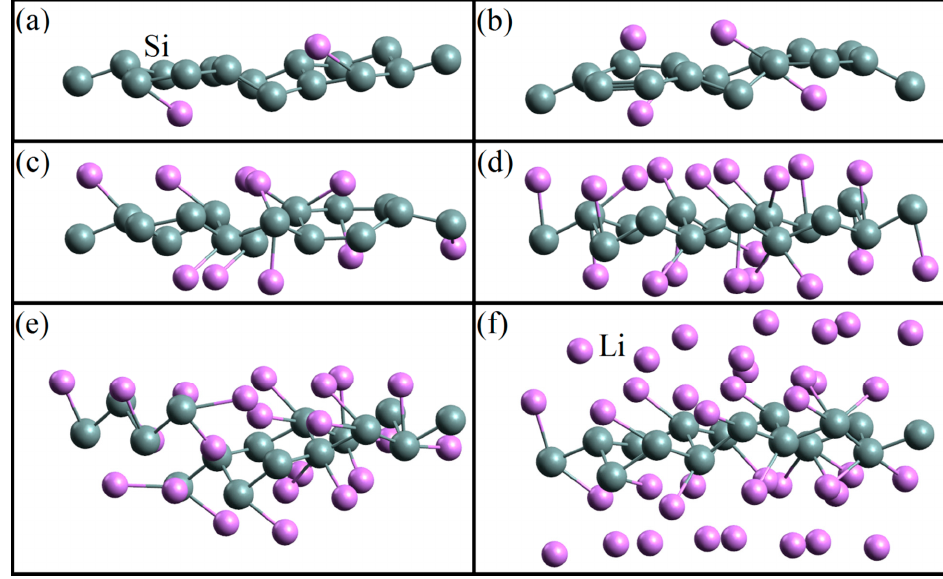
Figure 12. Geometric structure of the silicene/lithium system corresponding to the adsorption ratios: ( a ) 0.125, ( b ) 0.25, ( c ) 0.625, ( d ) 1, ( e ) 1.375, and ( f ) 2.375.